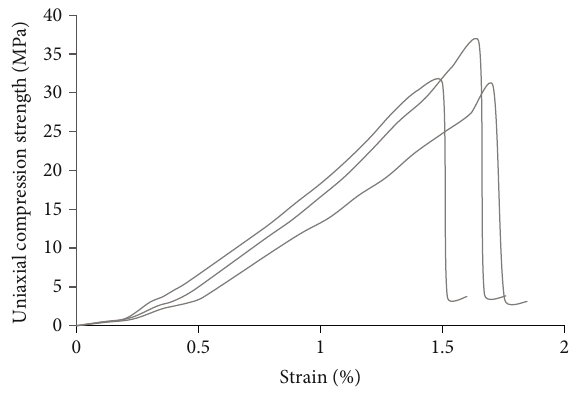
Figure 3: The stress-strain curve of the specimens in pure compression